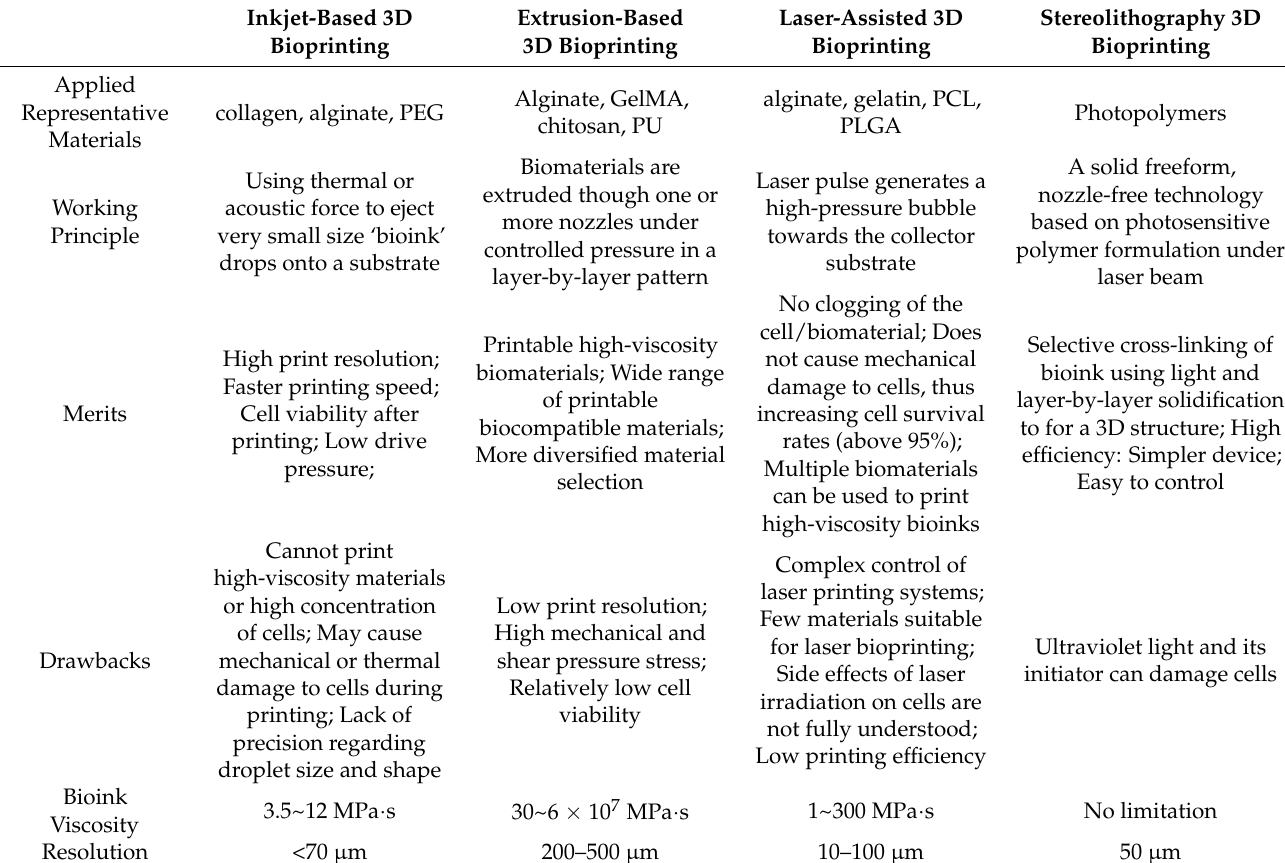
Table 2. Summary of common characteristics of 3D printing